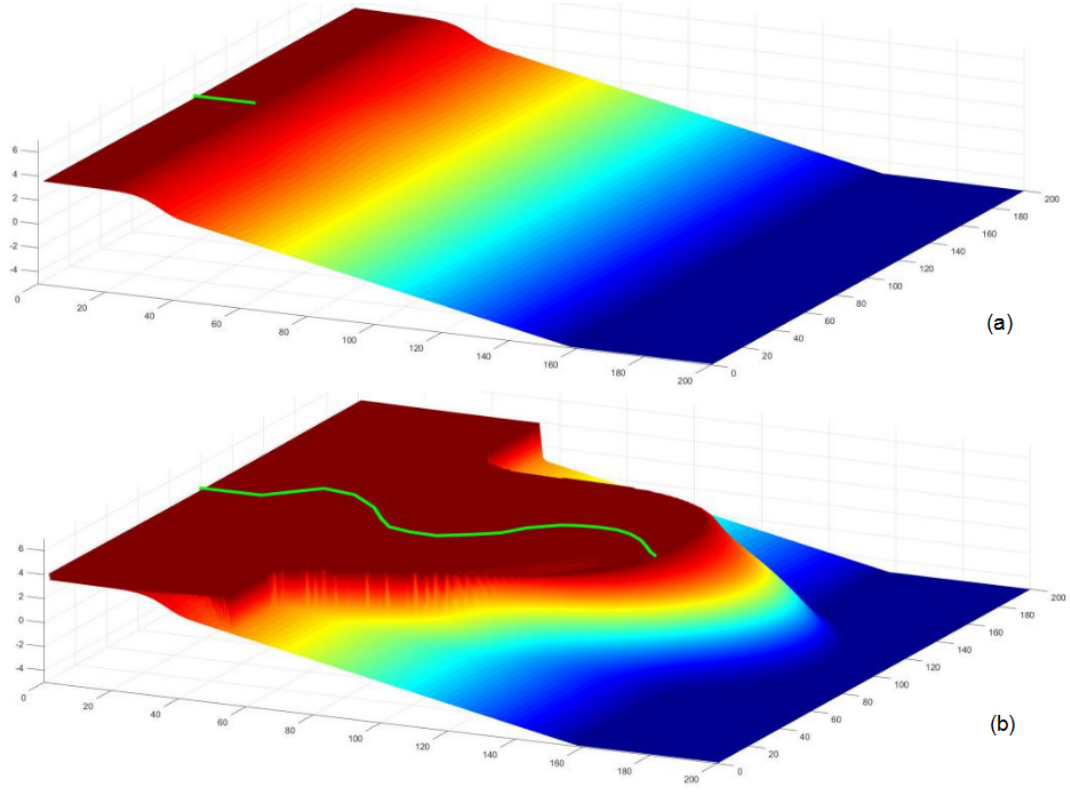
Figure 6. The initial topography and the simulated results of Model 1: (a) the initial topography and (b) the topography at t = 10Myr.